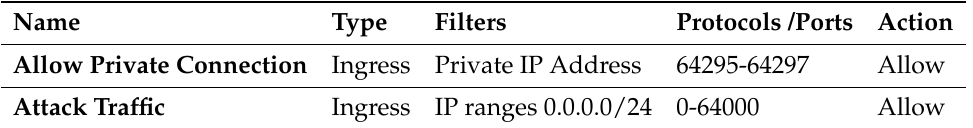
Table 3. Firewall Rules for All